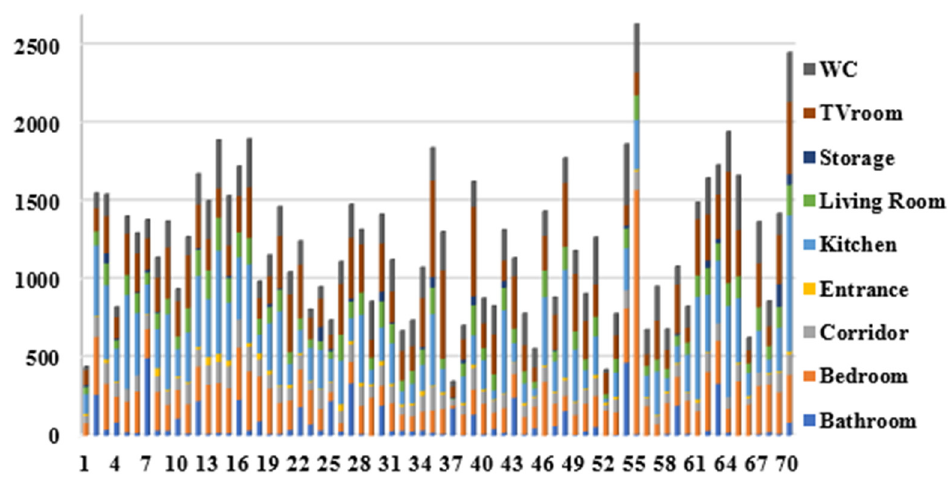
Figure 14. The total number of captured events per location for re-deployment testbed dataset.